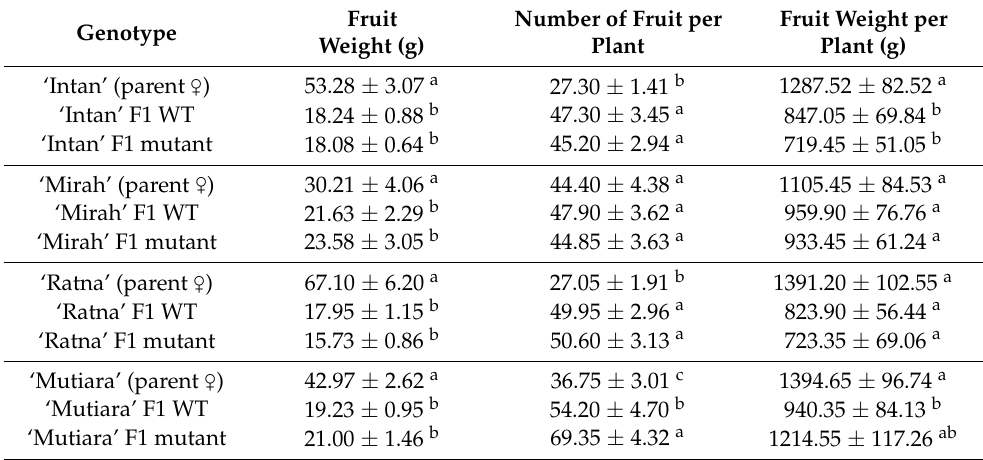
Table 4. Yield-related traits of F 1 generation in four tropical tomato genetic backgrounds.